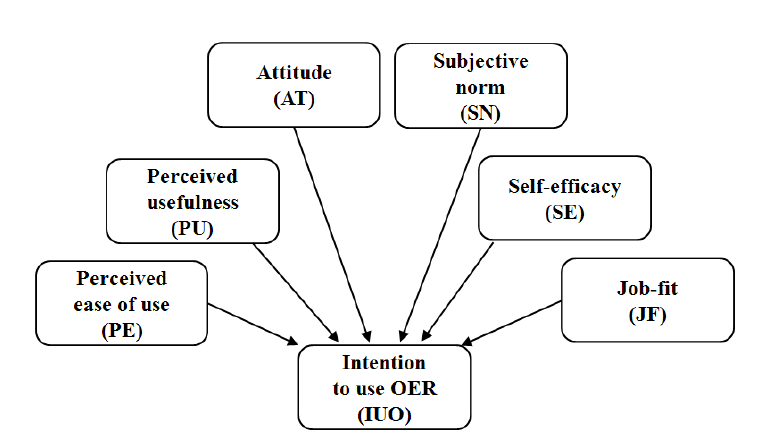
Figure 1 . Graphical sketch of the research